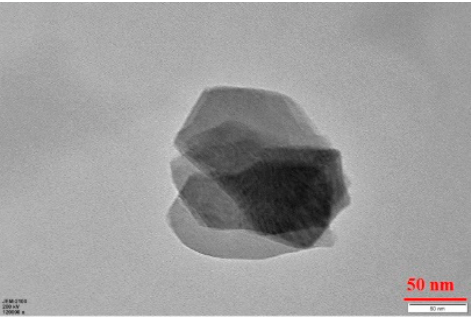
Figure 2. Transmission electron microscope (TEM) image of ReSe 2 dispersion solution.